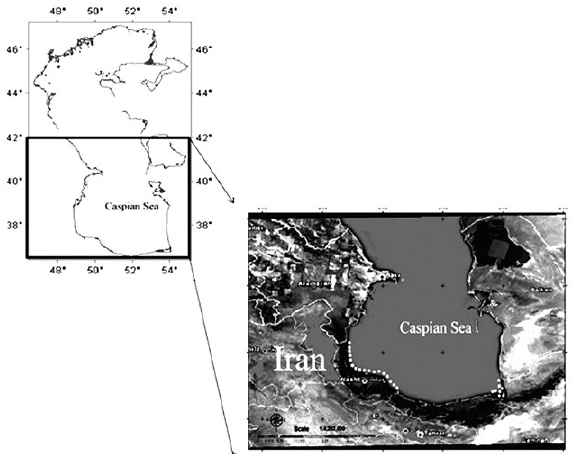
Fig. 1. – Location of sampling areas (white closed circles) of juve- nile Persian sturgeon in Iranian coastal waters of the Caspian Sea between October 2012 and June